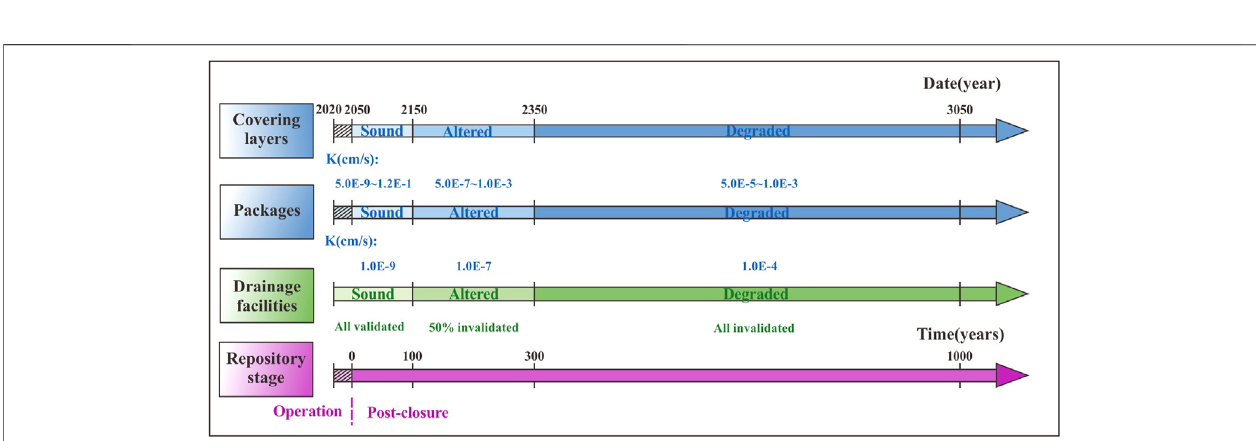
FIGURE 3 | Time phase and states of main facilities components in